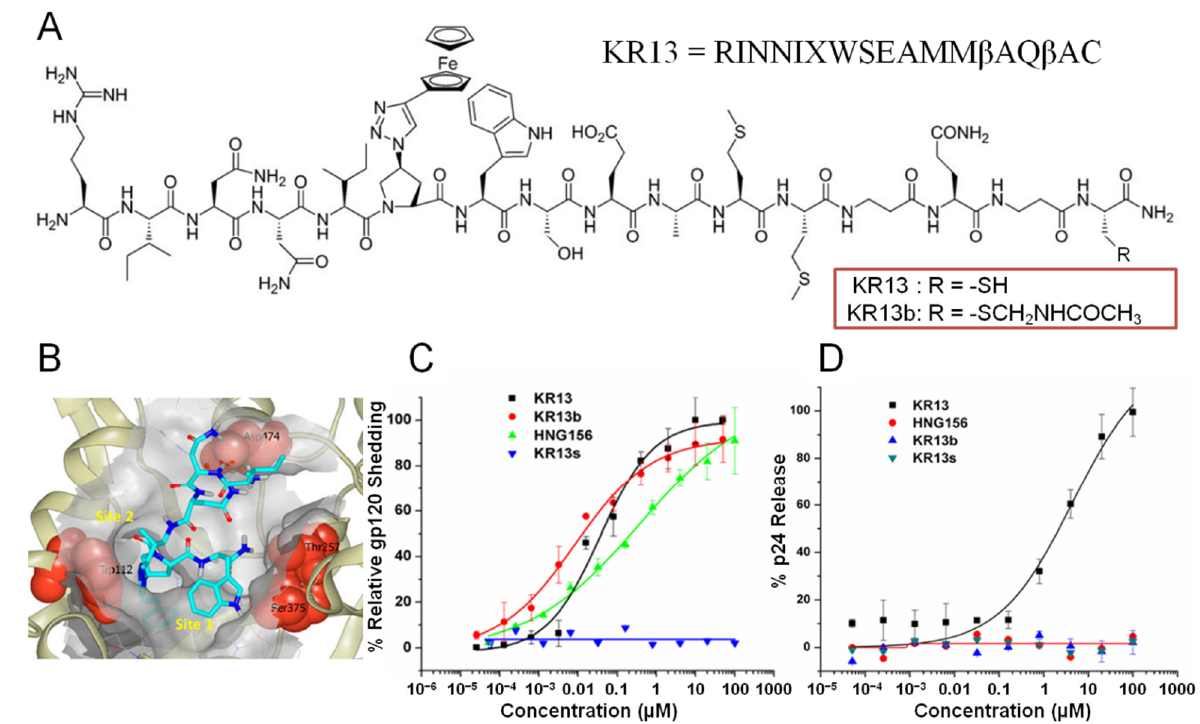
Figure 1. ( A ) Chemical structure and amino acid sequence of peptide triazole thiol (KR13) and blocked peptide triazole thiol (KR13b) compounds [22,23]. Reprinted (adapted) with permission from Bastian, A.R.; Kantharaju; McFadden, K.; Duffy, C.; Rajagopal, S.; Contarino, M.R.; Papazoglou, E.; Chaiken, I. Cell-free HIV-1 virucidal action by modified peptide triazole inhibitors of Env gp120. ChemMedChem 2011, 6, 1335-1339, 1318, doi:10.1002/cmdc.201100177. Copyright 2011 Wiley-VCH Verlag GmbH& Co. KGaA, Weinheim. ( B ) Localization of the IXW pharmacophore of a minimized peptide triazole to gp120 ′ s Phe43 pocket [27]. Hot spots Trp112, Thr257, and Asp474 are shown as CPK in red. The Trp residue rests in site 1, whereas the triazole moiety is buried in site 2. Reprinted (adapted) with permission from Aneja, R.; Rashad, A.A.; Li, H.; Kalyana Sundaram, R.V.; Duffy, C.; Bailey, L.D.; Chaiken, I. Peptide Triazole Inactivators of HIV-1 Utilize a Conserved Two-Cavity Binding Site at the Junction of the Inner and Outer Domains of Env gp120. Journal of medicinal chemistry 2015, 58, 3843–3858, doi:10.1021/acs.jmedchem.5b00073. Copyright 2015 American Chemical Society. ( C ) Env gp120 shedding and ( D ) Virolysis of BaL.01 pseudovirus by KR13, non-thiol parent PT HNG156, blocked-thiol PTT KR13b, and IWX scrambled pharmacophore PTT KR13s [23]. Figures in C and D reproduced with permission from Bastian, et al., Retrovirology; published by BioMed Central, Ltd. 2013